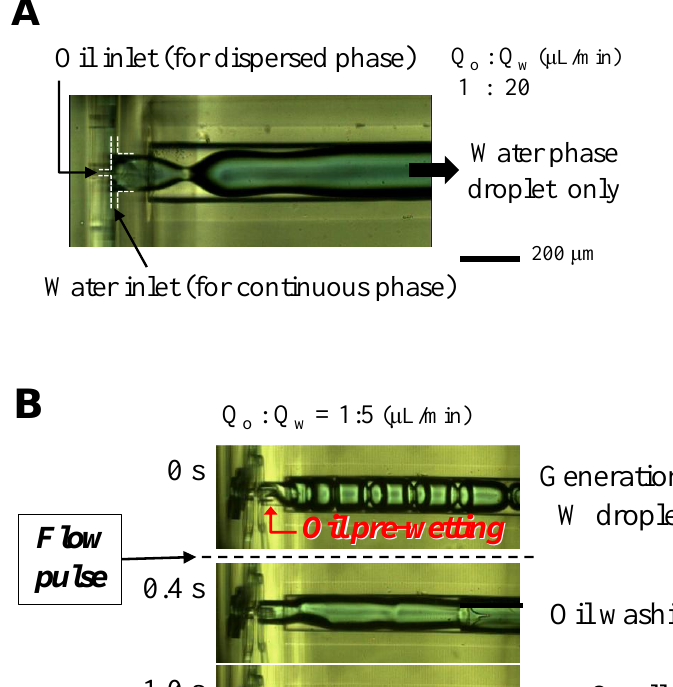
Figure 6. Similar to other droplet formation mechanisms, the droplet size was proportional to the flow rate of the dispersed phase fluid and inversely proportional to the flow rate of the continuous phase fluid. When the flow rate of the dispersed phase was about 1.5 times as large as the flow rate of the continuous phase, stable droplet formation in the dripping mode was changed to the unstable jetting mode or continuous flow. The droplet length ranged from 180 to 330 µ m in the structure, and the Figure 5 standard deviation was smaller than 5% under the fluidic conditions of the stable dripping mode.